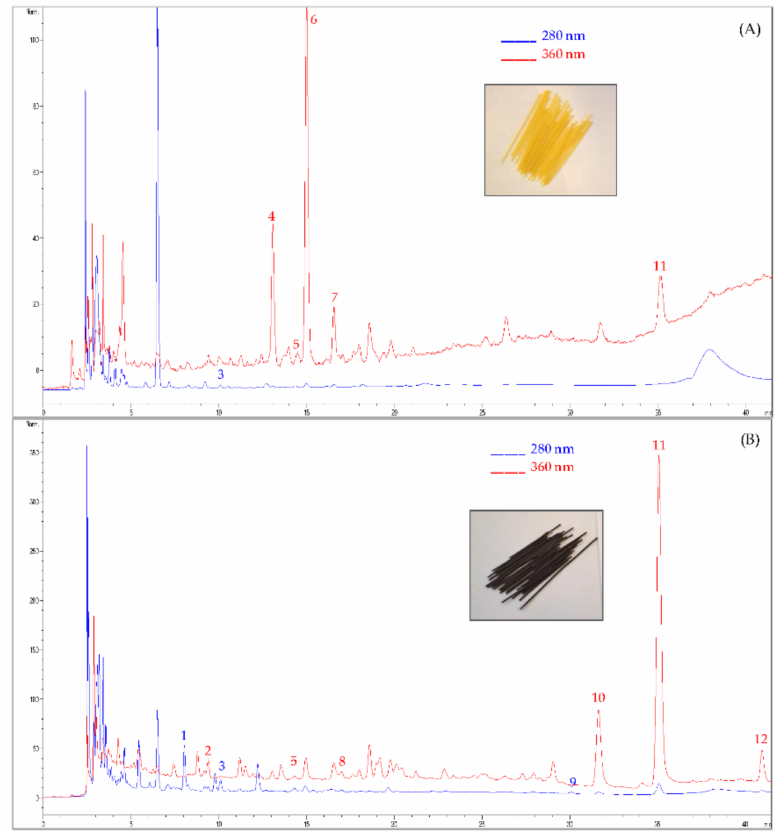
Figure 1. High Performance Liquid Chromatography-Diode Array Detector (HPLC-DAD) profile of control spaghetti ( A ) and spaghetti enriched with 10% olive paste flour ( B ). Polyphenols